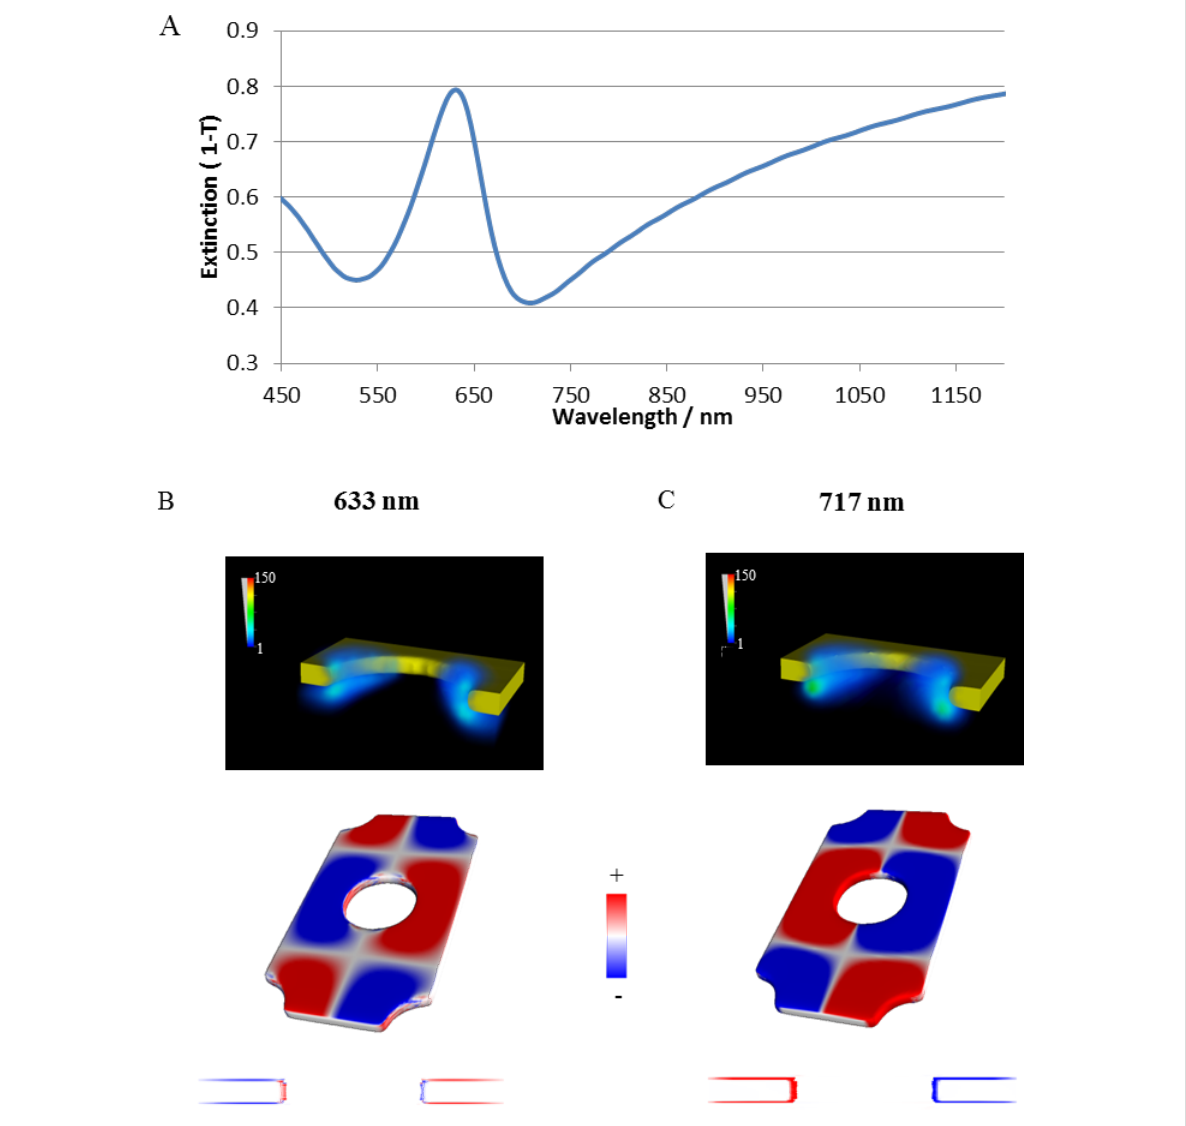
Figure 3: A) Simulated extinction spectra of a hole array (holes diameter 110 nm) in 20 nm thick gold film. Underneath the E-field intensity (| E | 2 /| E 0 | 2 ) and charge density plots for the peak at 633 nm (B) and dip at 717 nm (C) is shown. The direction of the light propagation is normal to the surface and the polarization horizontal in the figure